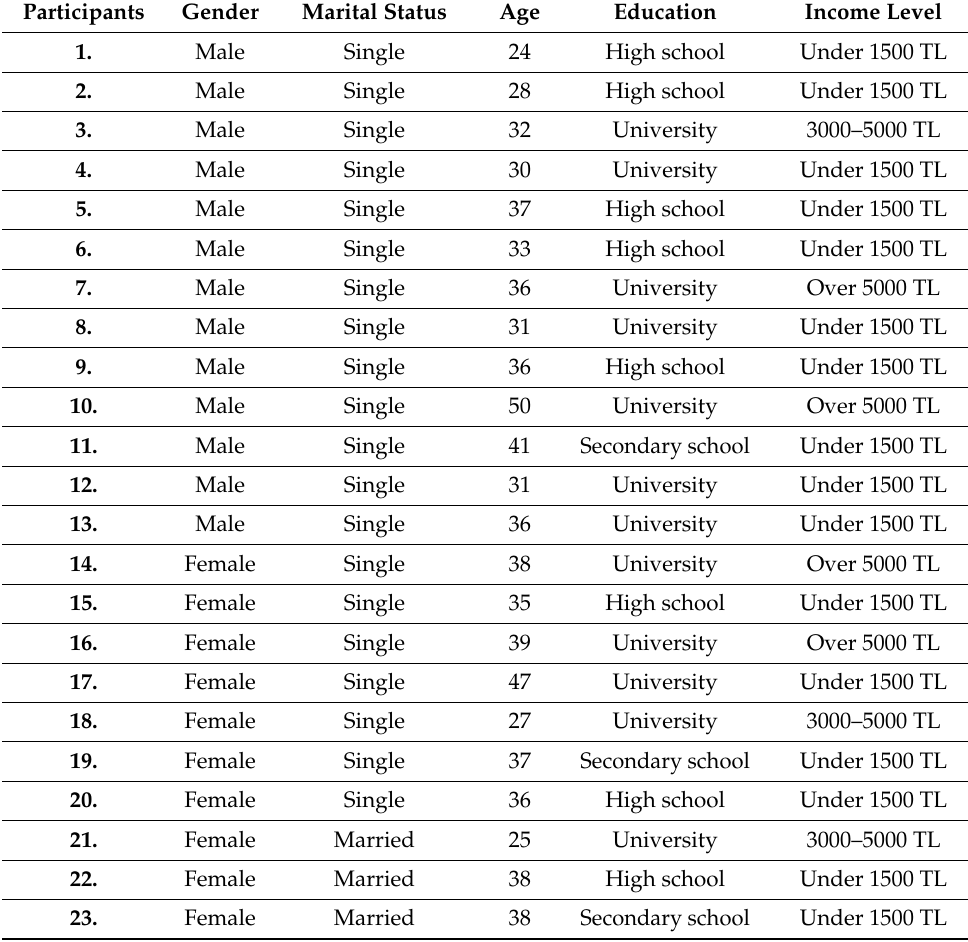
Table 1. Socio-demographic profile of the